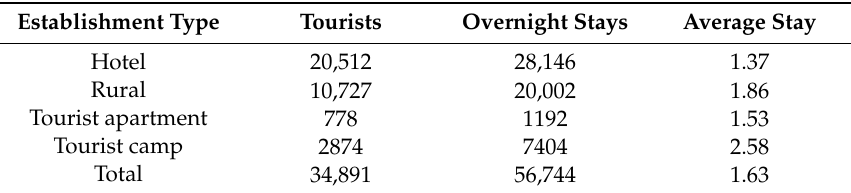
Table 1. Tourist indicators of the geopark